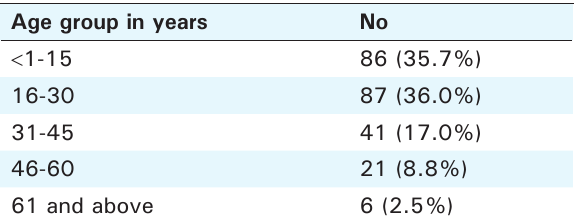
Table 4. Age distribution of patients on